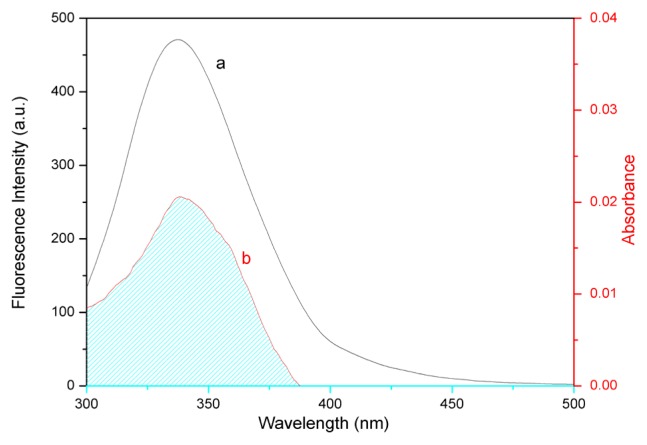
The overlap of the fluorescence emission spectrum of BSA (a) with the absorption spectrum of eupatorin; (b) CBSA = Ceupatorin = 3.0 × 10−7 M, T = 298 K, and pH 7.4; λex = 280 nm, λem = 290–500 nm.